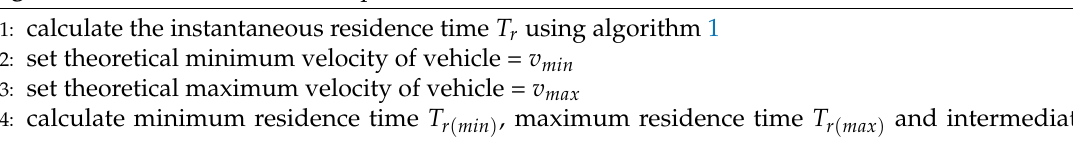
Algorithm 2 Batch selection and